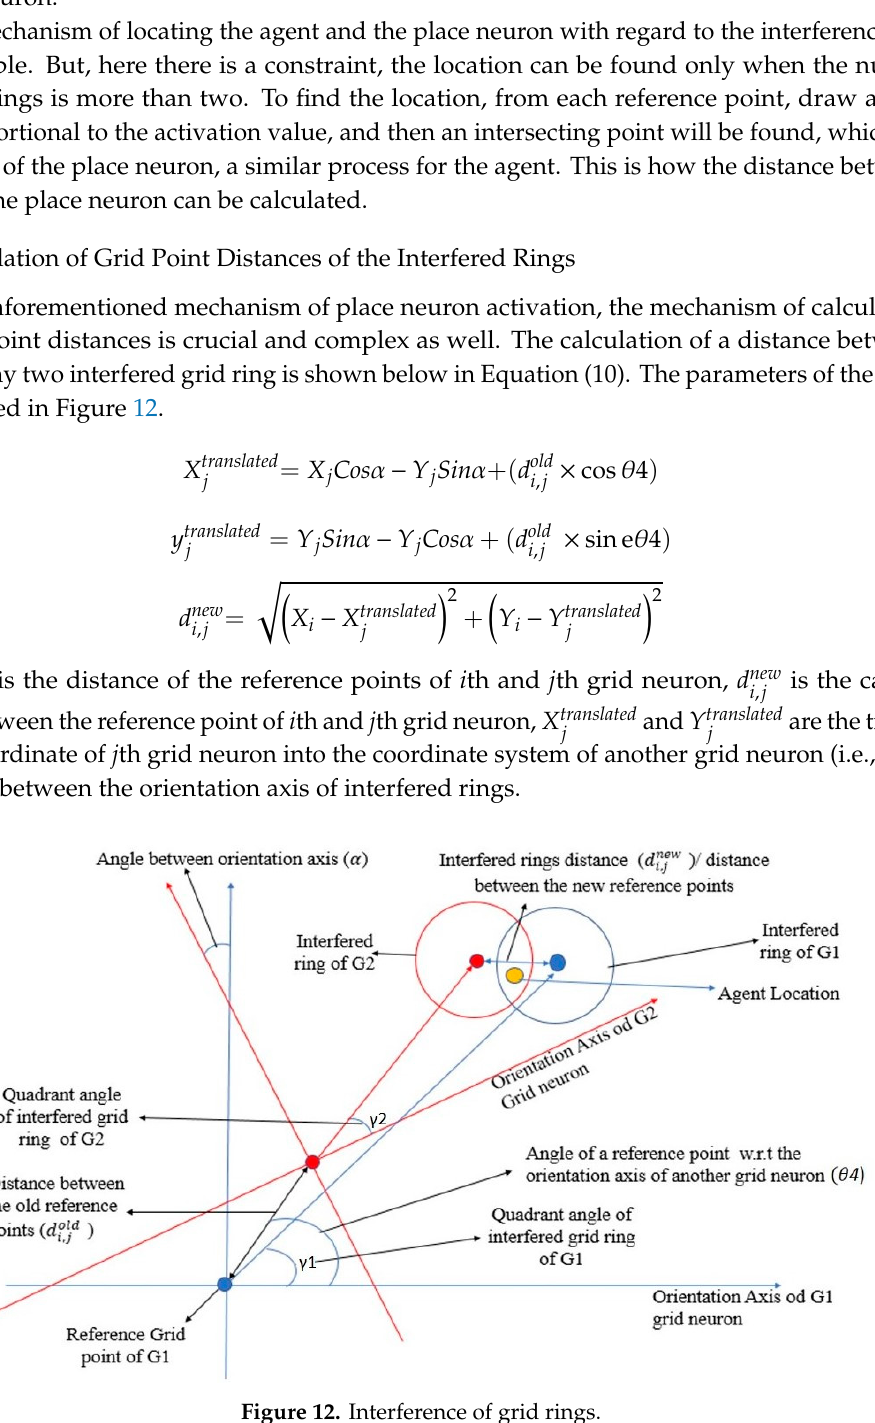
Figure 12. Interference of grid rings.